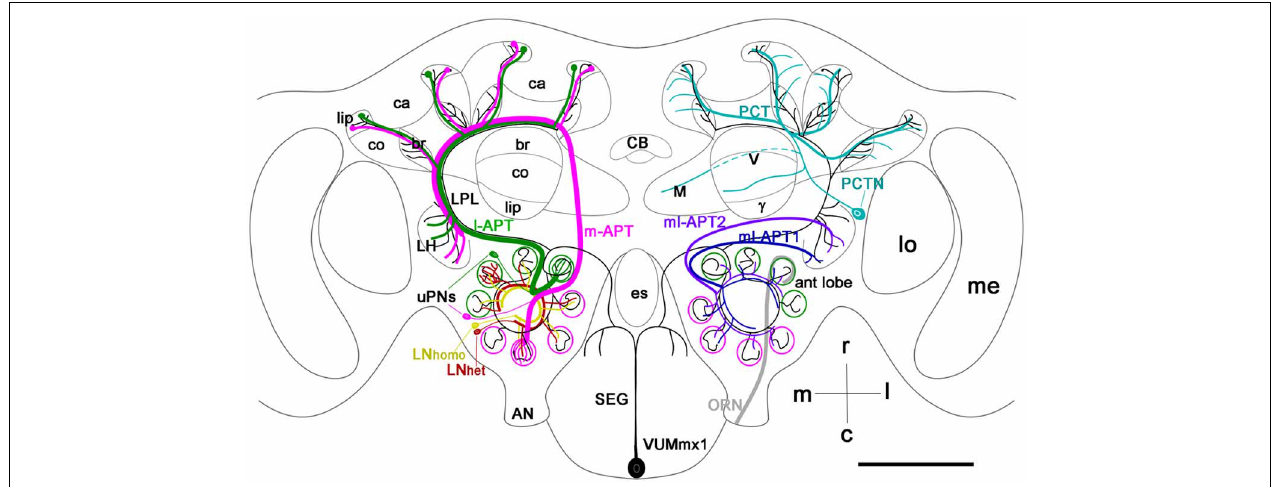
FIGURE 1 | Schematic view of the main olfactory pathways in the honey bee brain (based on Fonta et al., 1993; Abel et al., 2001; Strausfeld, 2002; Sinakevitch et al., 2005, 2011; Kelber et al., 2006; Kirschner et al., 2006; Schröter et al., 2007; Girardin et al., 2013). Olfactory Receptor Neuron (ORN) axons from the antenna enter through the antennal nerve (AN) into the antennal lobe (ant lobe) and converge onto the outer cortex of glomeruli. Each glomerulus is innervated by processes of several types of neurons. Uniglomerular projection neurons (uPNs magenta and green) have dendritic branches in a single glomerulus and send axons to higher-order brain centers such as the MB calyces (ca), lateral protocerbral lobe (LPL), and lateral horn (LH). There are two uniglomerular antenno-protocerebral tracts, the l-APT (green) and m-APT (magenta), which reflect the segregation of glomeruli into rostral (l-APT) and caudal (m-APT) hemispherical clusters. Kenyon cells (not shown in the figure) are the intrinsic cells that make up the MB. Kenyon cell dendrites form pairs of calyces (ca) with specific zones that receive different